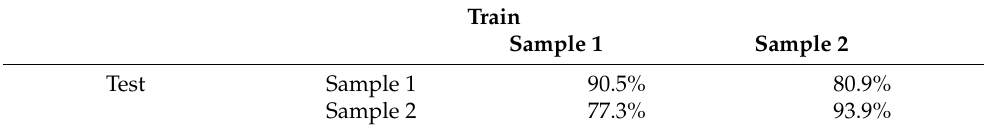
Table 8. F1 Scores.